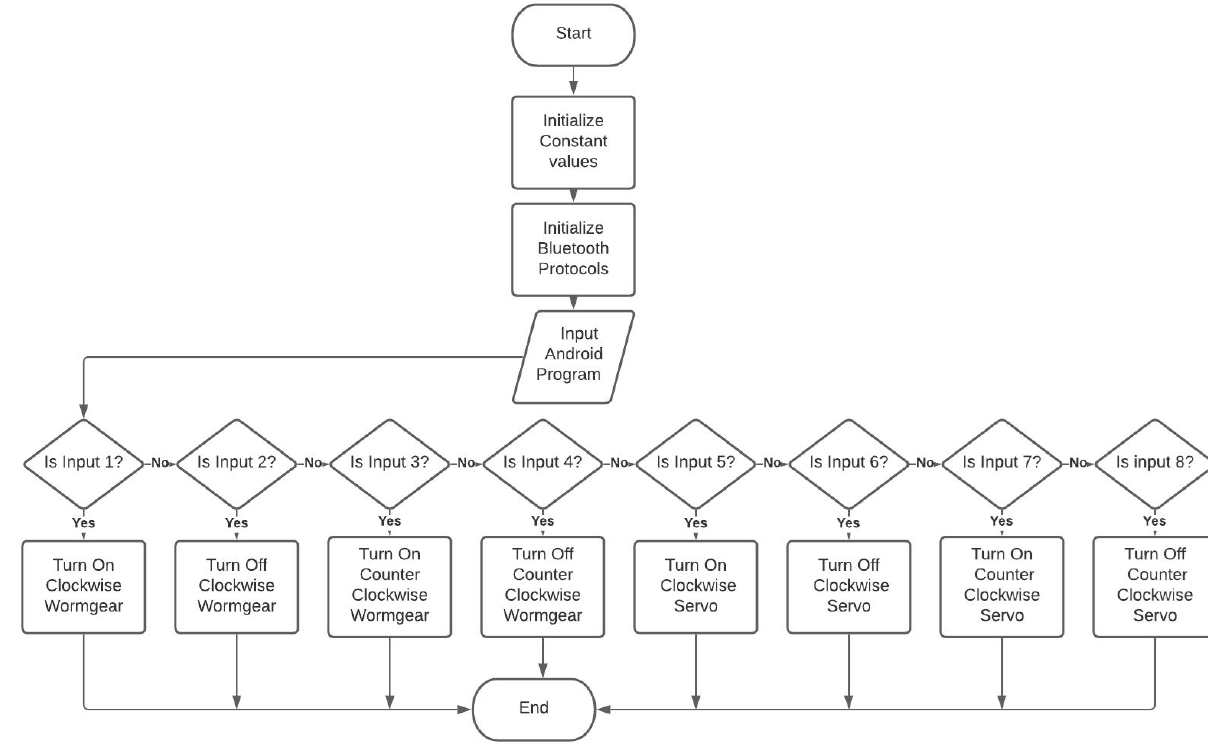
Figure 4: Flow chat of the program for the Arduino control module